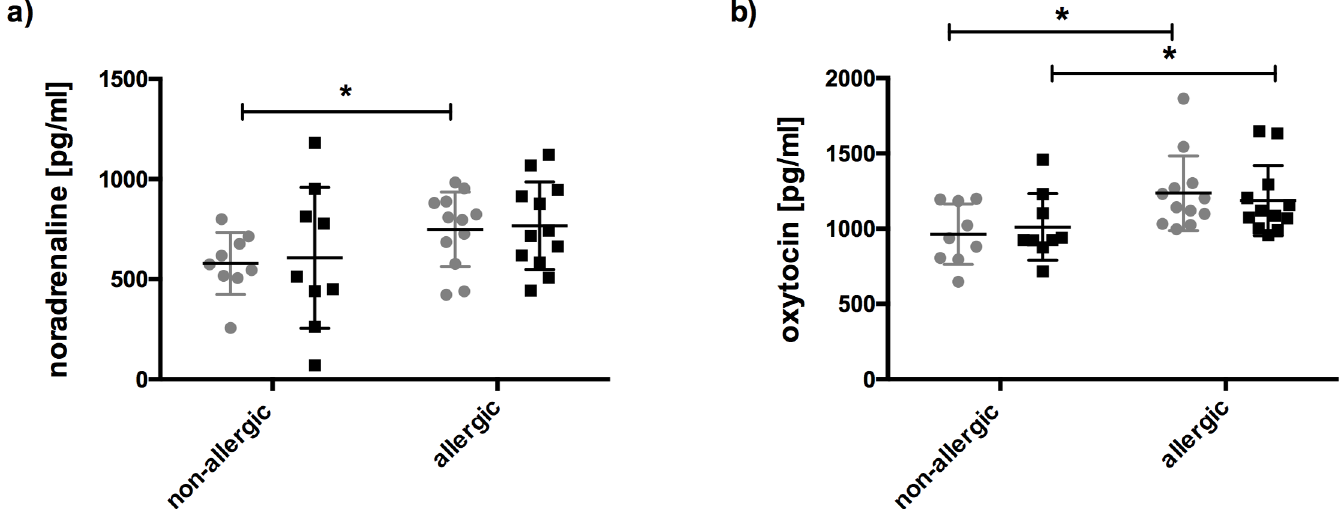
Fig 5. Significantly higher baseline levels of noradrenaline and oxytocin in allergic patients. Samples of cortisol-responding allergics (n = 12) and non-allergics (n = 9) were tested before TSST (grey dots) or after (black) for a) plasma noradrenaline and b) oxytocin levels. Data are represented as means ± SD; (cid:3) p (cid:20) 0.05.